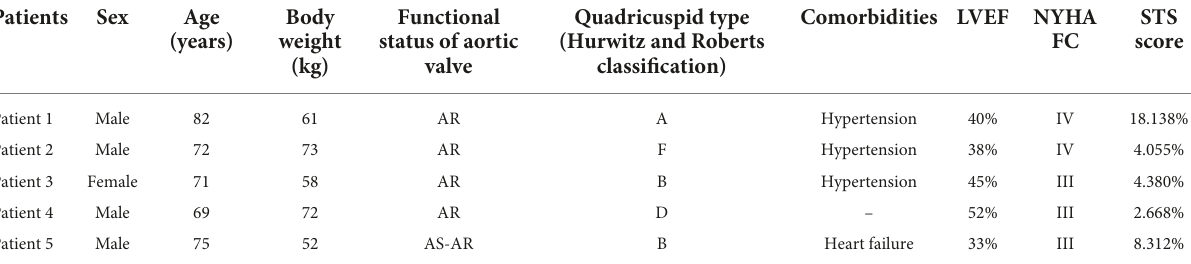
TABLE 1 Preoperative clinical characteristics.